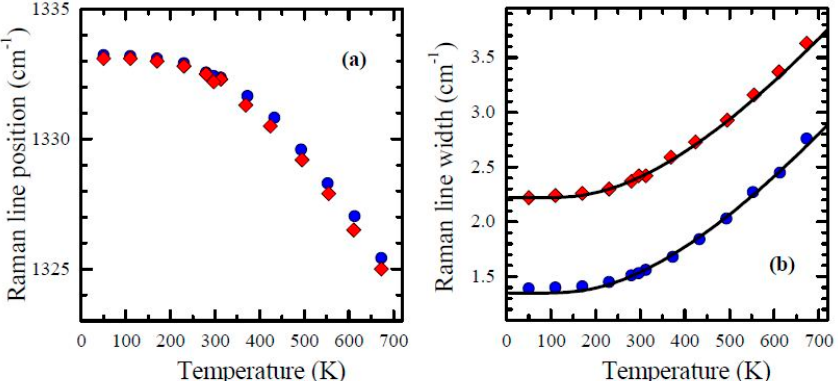
Figure 3. Temperature dependences of the Raman line parameters of the nitrogen-containing diamond (diamonds) and defect-free diamond (circles): ( a ) line position; ( b ) Lorentzian line width. The lines depict fits by Equation (1) (see text for details).